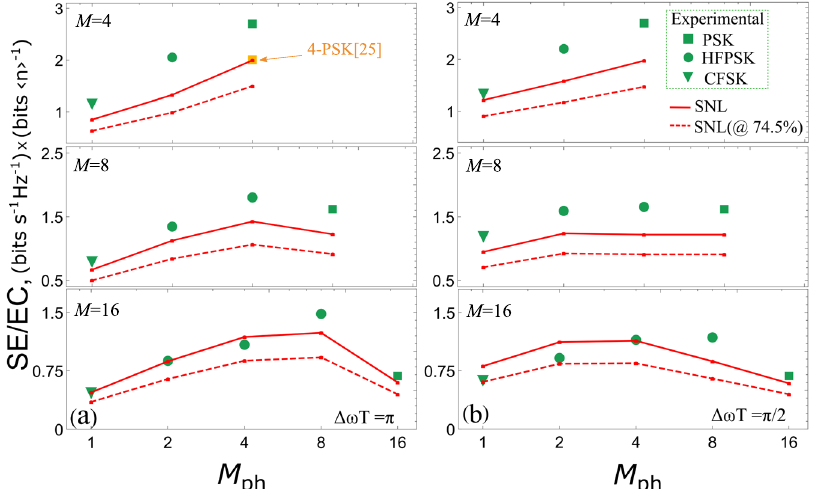
Fig. 5 Combined resource ef fi ciency at SER = 15% plotted against M ph for different alphabet lengths M . Number of frequencies in an alphabet is M f = M / M ph . Green fi lled triangles, circles and squares represent experimental results for CFSK, HFPSK and PSK, respectively. Red dots connected with solid and dashed guide lines represent the absolute SNL and the SNLs adjusted for system ef fi ciency, respectively. Measurements are performed for two different detunings ( a ) Δ ω T = π and ( b ) Δ ω T = π /2. The experimental error bars are smaller than data